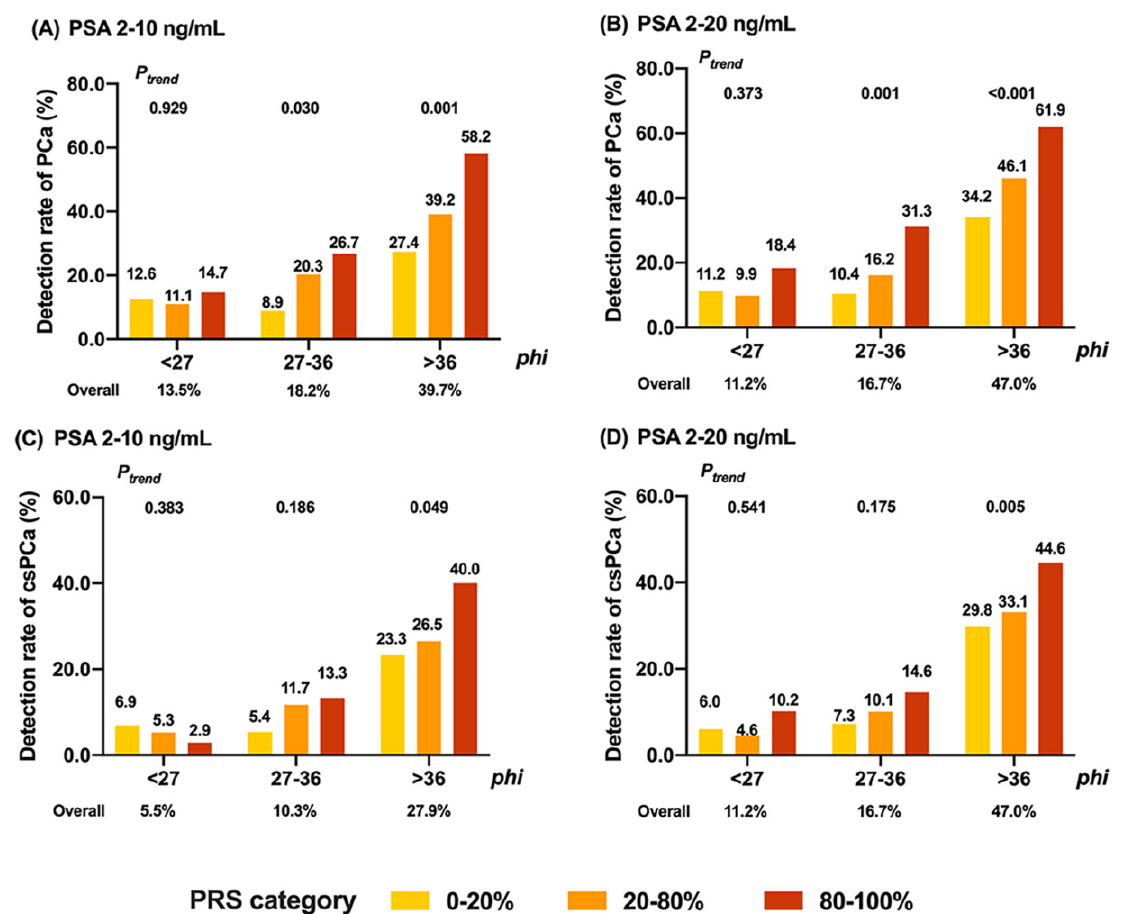
Figure 2. Detection rates of PCa based on quintiles of PRS in different subgroups. ( A ) The detection rates of PCa based on quintiles of PRS in PSA at 2–10 ng/mL. ( B ) The detection rates of PCa based on quintiles of PRS in PSA at 2–20 ng/mL. ( C ) The detection rates of csPCa based on quintiles of PRS in PSA at 2–10 ng/mL. ( D ) The detection rates of csPCa based on quintiles of PRS in PSA at 2–20 ng/mL. Abbreviation: PCa, prostate cancer; csPCa, clinically significant prostate cancer; PRS, polygenic risk score. Ptrend was determined by the Cochran–Armitage trend test.